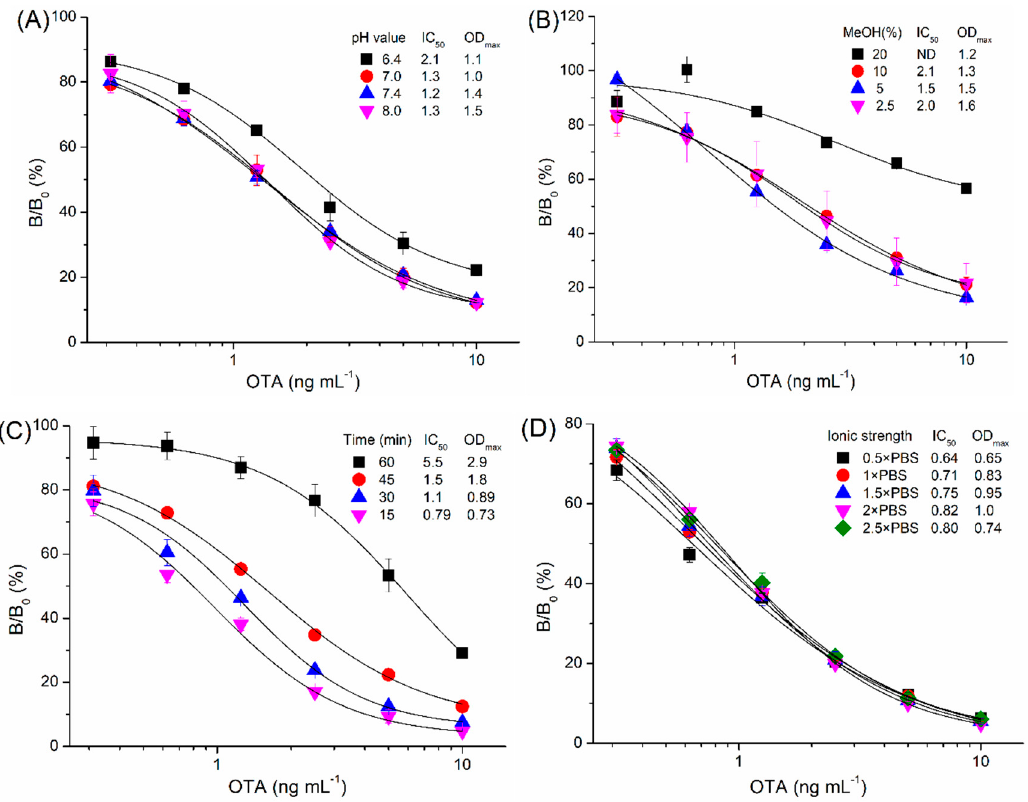
Figure 3. Effects of pH value ( A ), methanol ( B ), competitive time ( C ), and ionic strength ( D ) on the performance of Nb-AP-based one-step ELISA. The error bars represent the standard deviation of three independent tests.